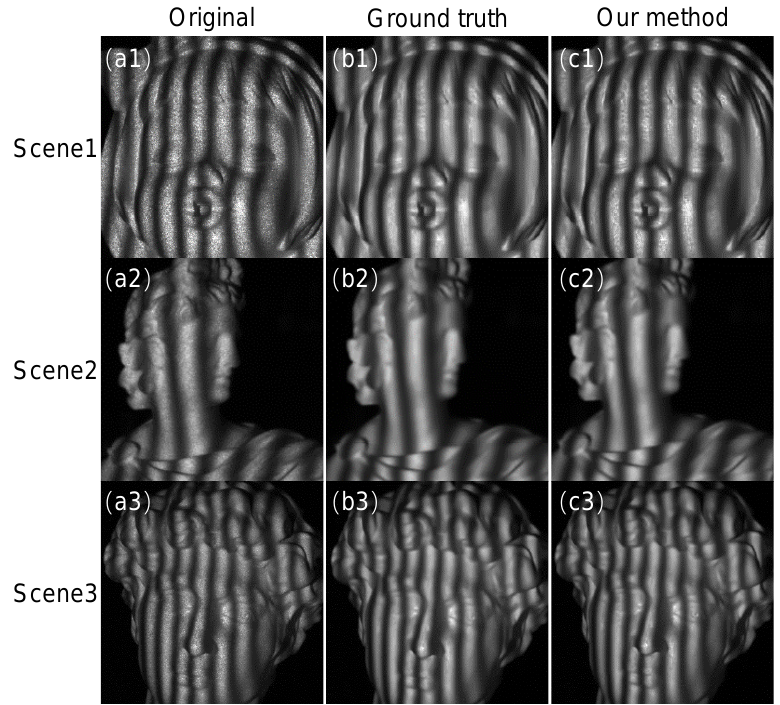
Figure 5. The performance of the trained CNN1. ( a1 – a3 ) The captured raw NIR fringe patterns of different scenes. ( b1 – b3 ) The ground-truth-filtered NIR fringe patterns processed by BM3D. ( c1 – c3 ) The filtered NIR fringe patterns obtained by